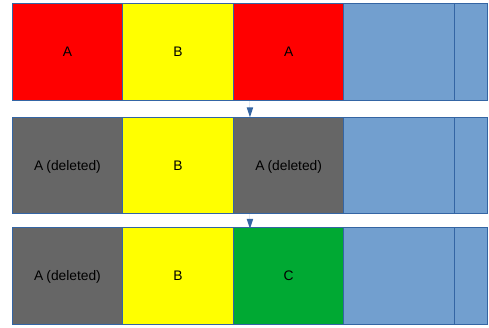
Figure 8. Test Case 6. Fragmented file A is deleted. File A is then partially overwritten by file C.